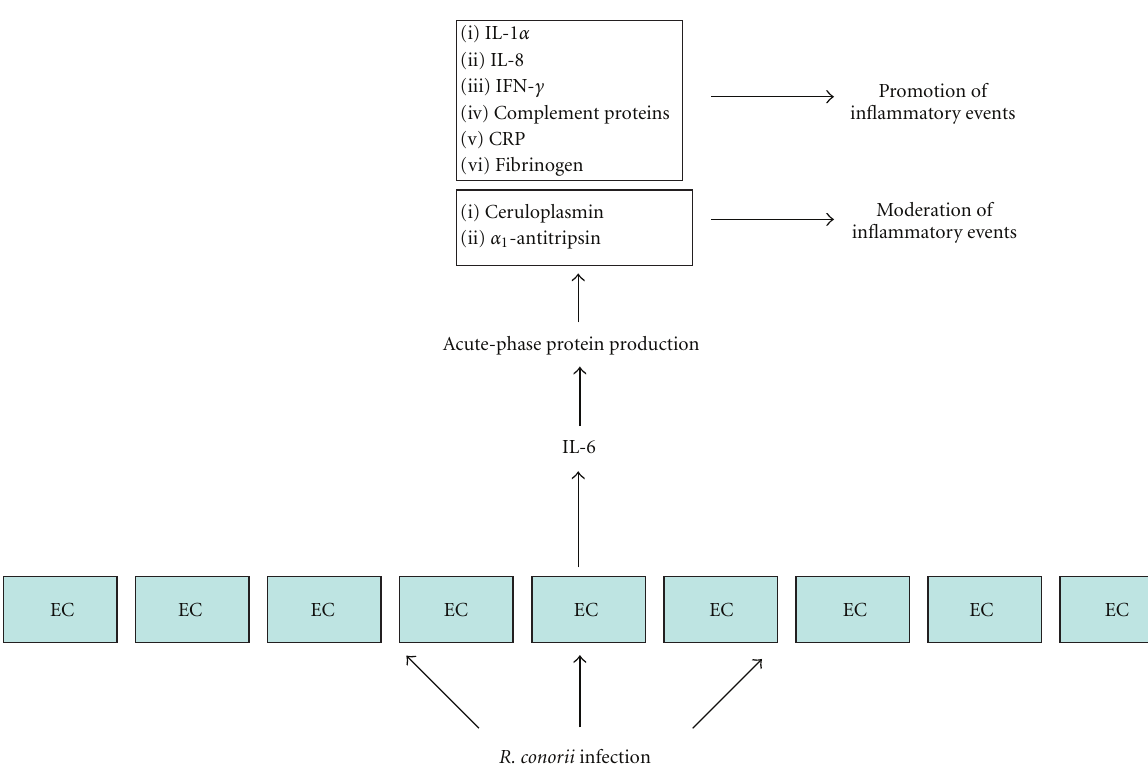
Figure 4: Acute phase response in rickettsial